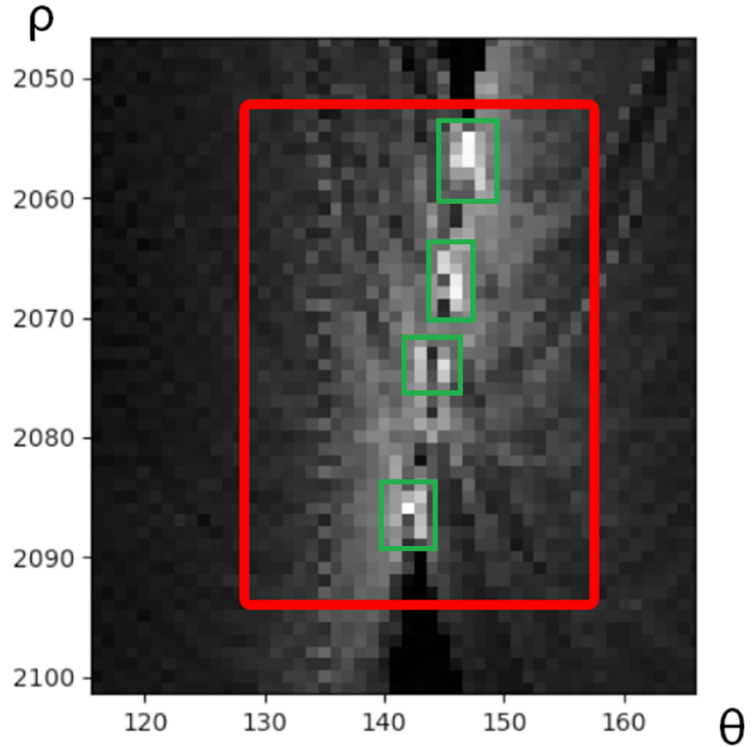
Figure 21. Four candidates in the same rectangle validating a double lane marker.